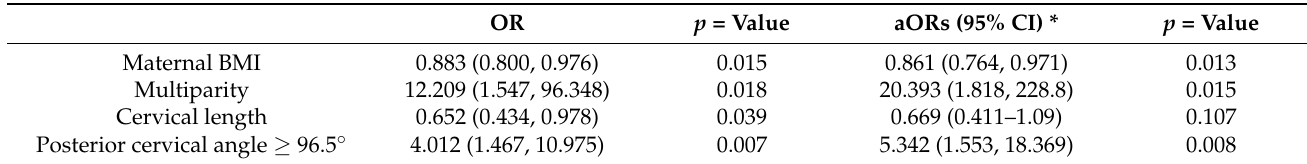
Table 3. Logistic regression analysis for likelihood of vaginal